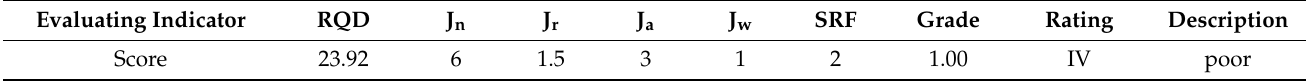
Table 2. Quality classification of Barton rock mass.